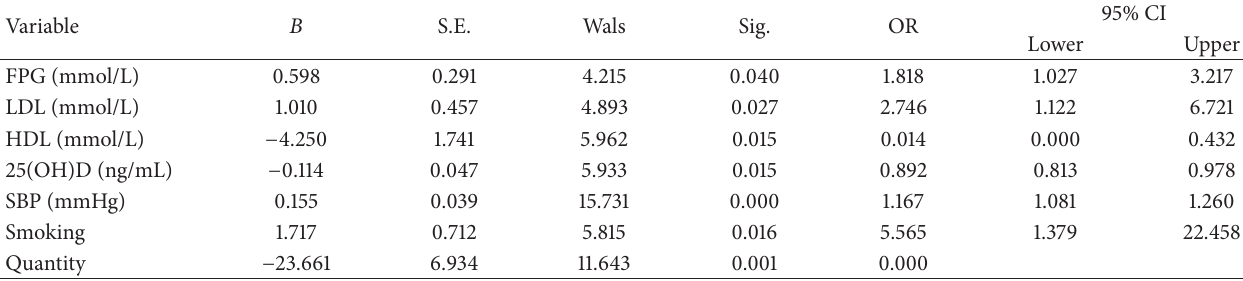
Table 5: Multivariable logistic regression analysis for the predictors of